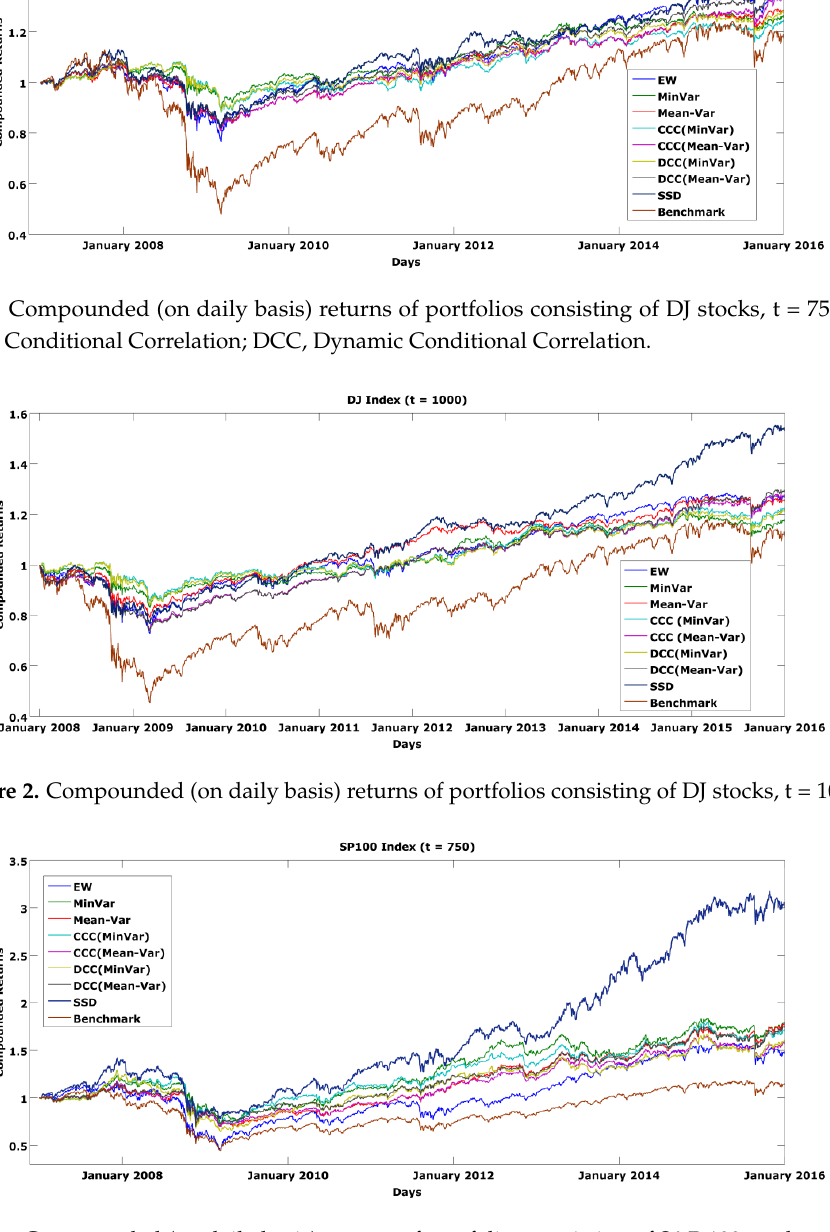
Figure 3. Compounded (on daily basis) returns of portfolios consisting of S&P 100 stocks, t = 750.